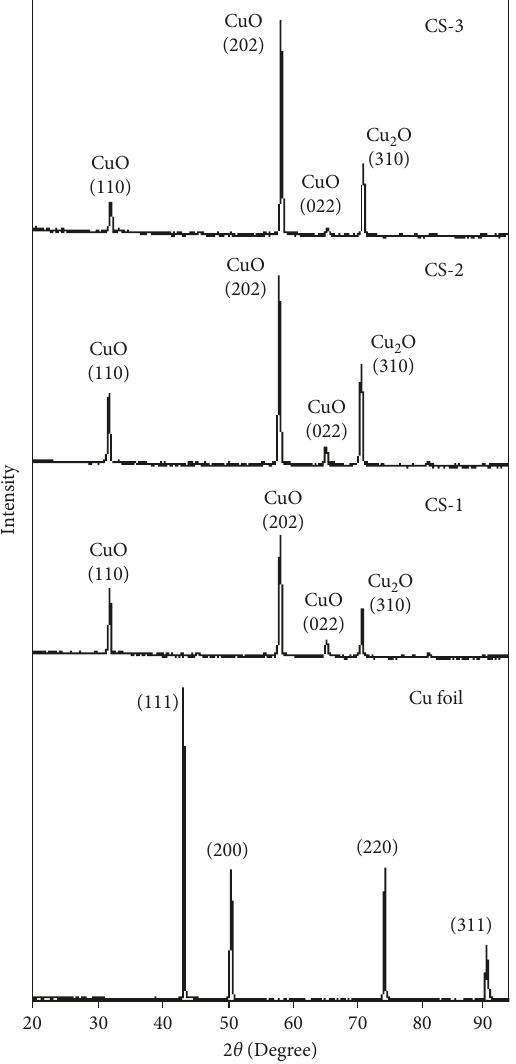
Figure 3: XRD patterns in Cu oxide films grown on Cu